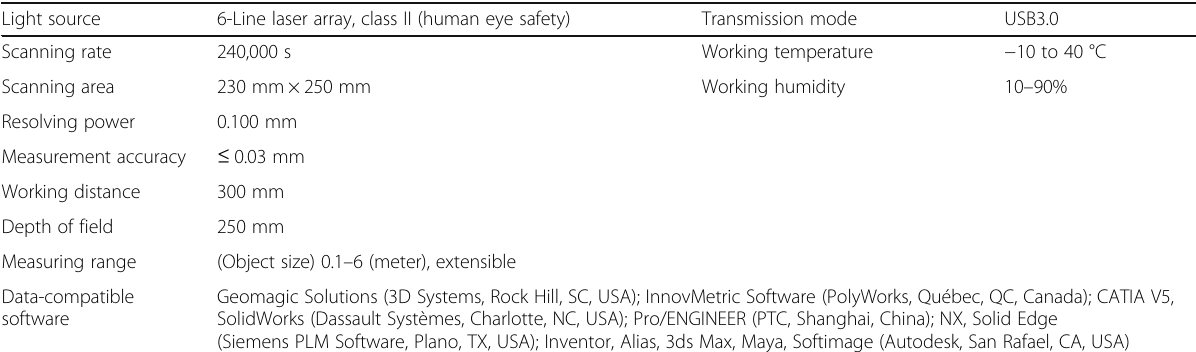
Table 2 Hand-held laser scanner parameter